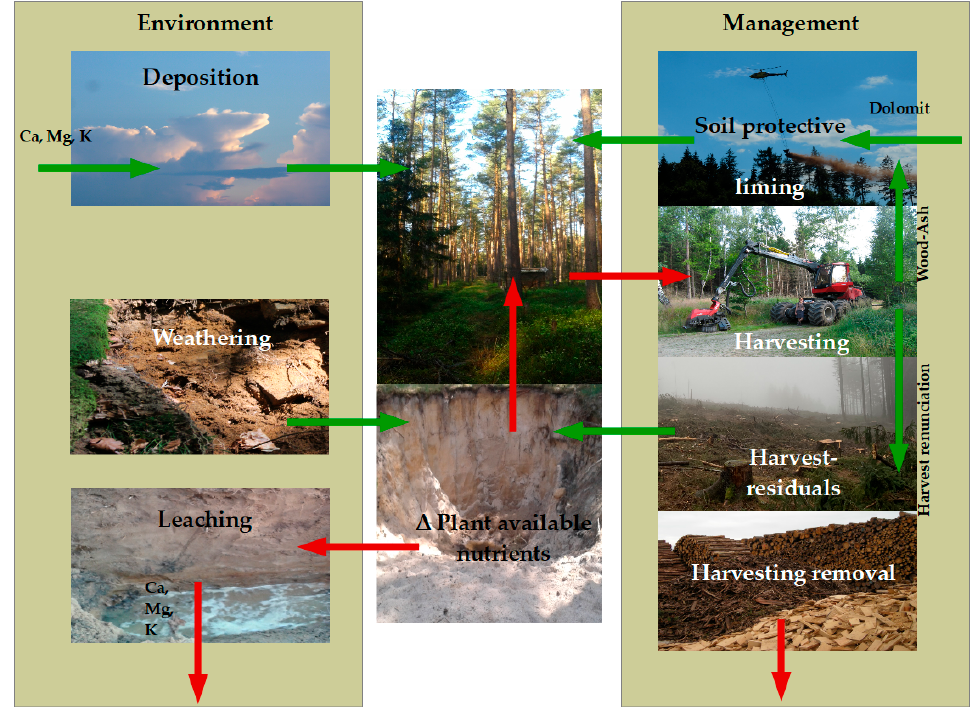
Figure 1. Schematic view of considered element fluxes for soil nutrient balances of Ca, Mg, and K in forest ecosystems and their relationships to each other. One 1000th of the plant-available nutrient stock in the soil is taken into account as an additional input